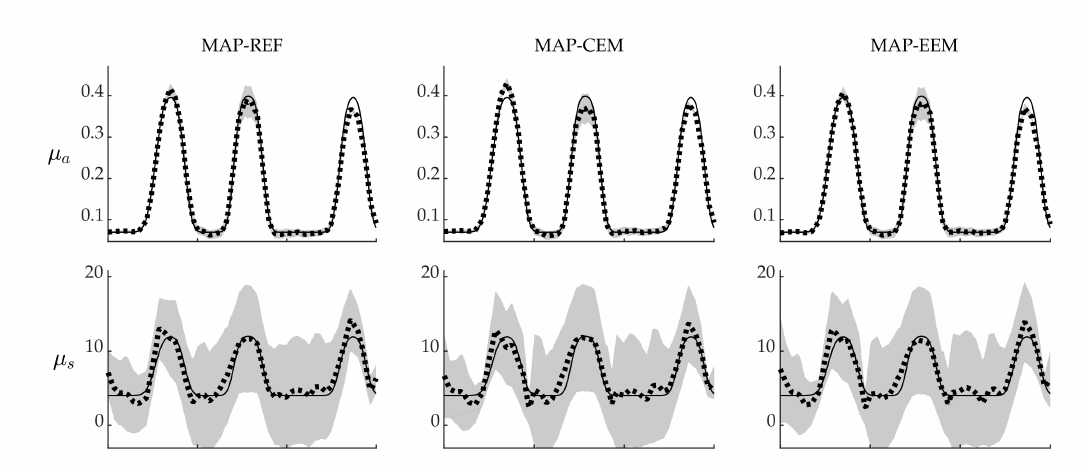
Figure 7. Gaussian approximations of the posterior distributions of the simulations with blood-vessel- mimicking inclusions along the cross-section shown in Figure 5. MAP-REF reconstructions ( first column ), MAP-CEM reconstructions ( second column ) and MAP-EEM reconstructions ( third column ). Solid line is the true value along the cross-section, dotted line is the MAP estimate and grey area covers the credibility interval [ ˆ µ − 3 σ ˆ µ , ˆ µ + 3 σ ˆ µ ] . The first row presents the absorption µ a ( mm − 1 ) and the second row the scattering µ s ( mm − 1 )